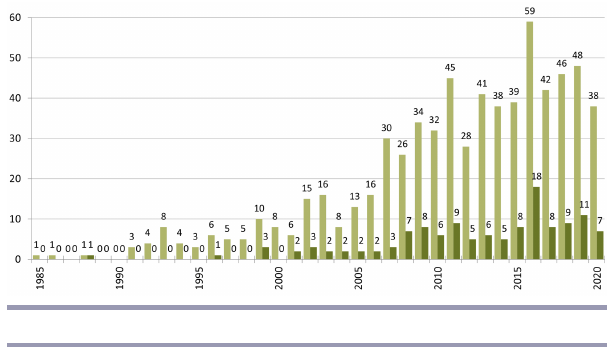
Fig. 3 . Number of scientific studies published on dehesas in general (light green, n = 679) and specifically on nature conservation issues (dark green, n = 128).